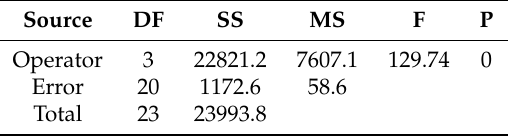
Table 10. ANOVA: production vs. operator.